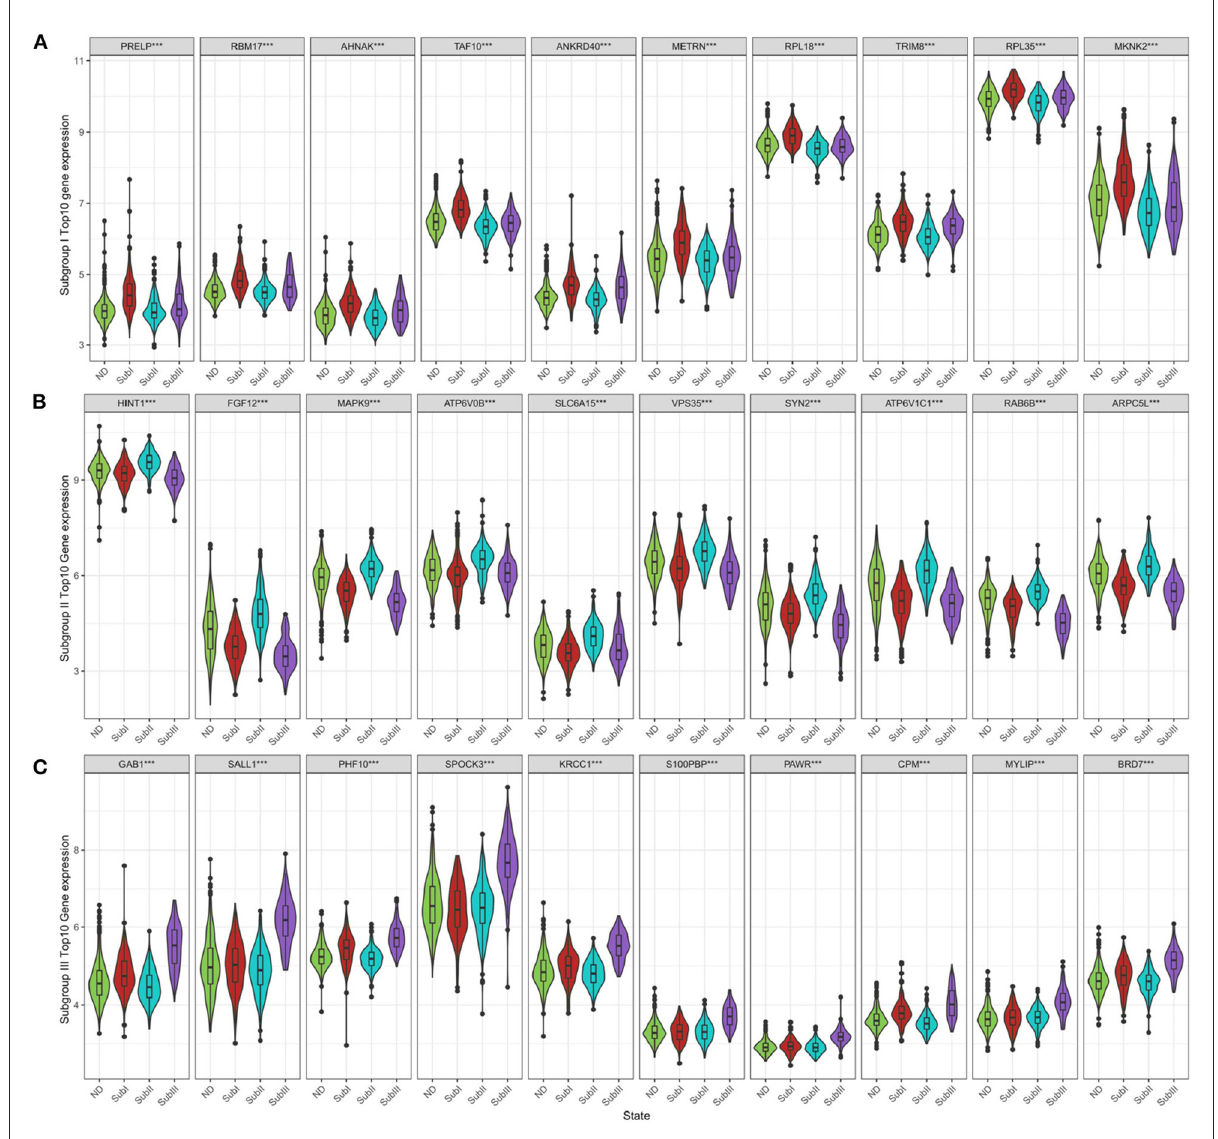
FIGURE9 Subgroup-specific gene expression. (A) Expression of subgroup I hub genes in each group. (B) Expression of subgroup II hub genes in each group. (C) Expression of subgroup III hub genes in each group. Kruskal–Wallis test, *** P <